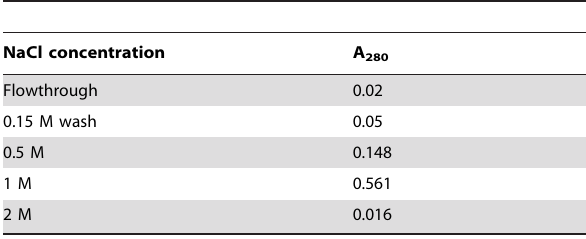
Table 1. 3.5 mg of peptide 6a-P was dissolved in 1 ml of 25 mM Tris, 0.15 M NaCl, pH